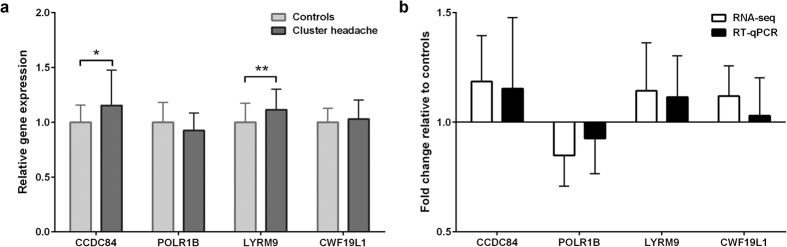
RT-qPCR validation of genes differentially expressed between cluster headache patients and controls.Four genes were chosen from the top 15 differentially expressed genes between participants with cluster headache and controls. Data were normalized to TBP mRNA expression. (a) Gene expression measured by RT-qPCR in the cluster headache group relative to the expression in the control group. (b) Comparison of fold-change of gene expression in participants with cluster headache relative to controls measured by RNA-seq and RT-qPCR. Means ± SD, *P < 0.05; **P < 0.01.